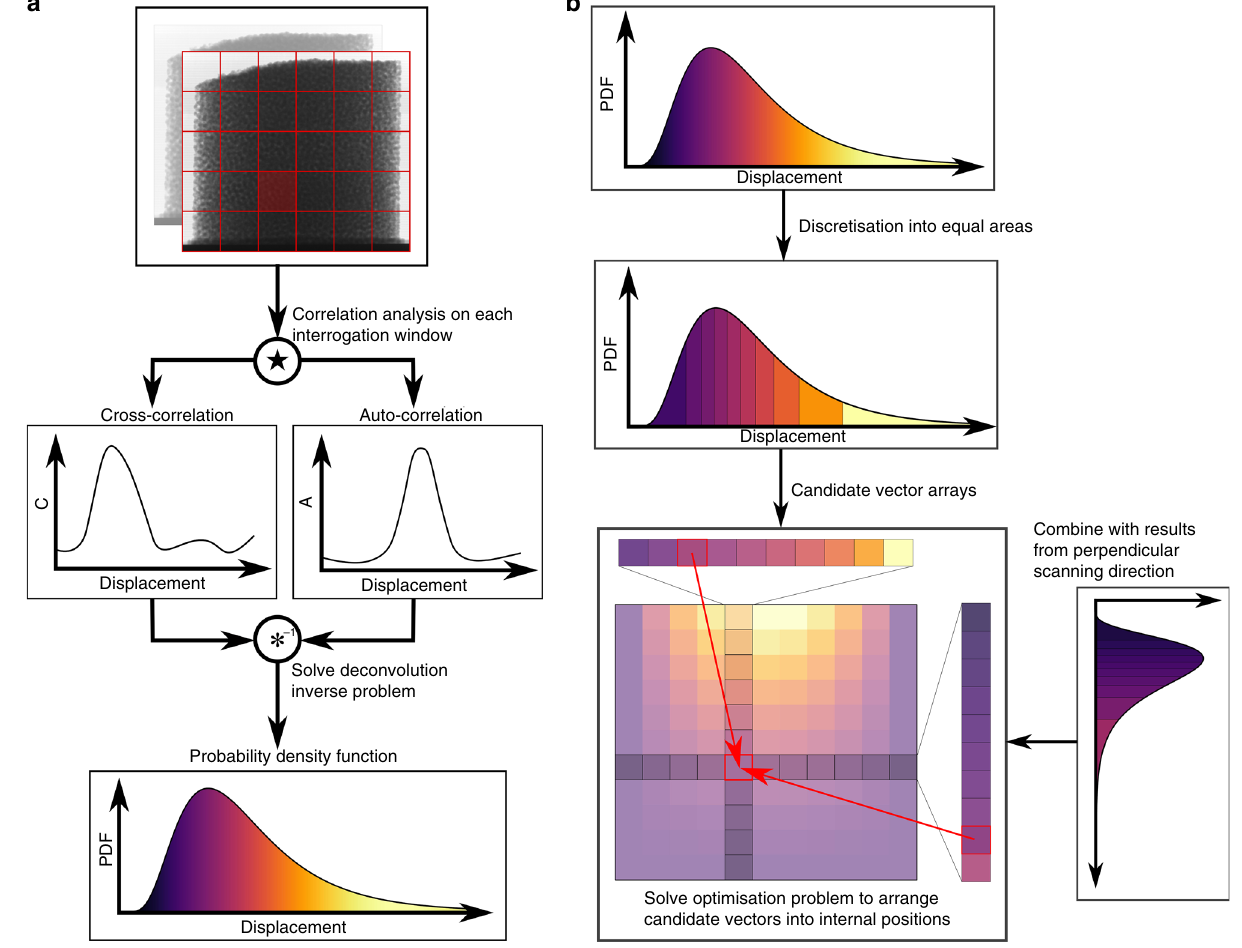
Fig. 3 Velocity reconstruction process. a An initial pair of radiographs (top) is divided into interrogation windows (red grid), with image correlation analysis then conducted on each window (middle) to extract the probability density function (PDF) of displacements in that window (bottom). b Displacement PDFs are discretised into candidate vectors and results are combined with orthogonal direction to arrange candidate arrays into the internal grid